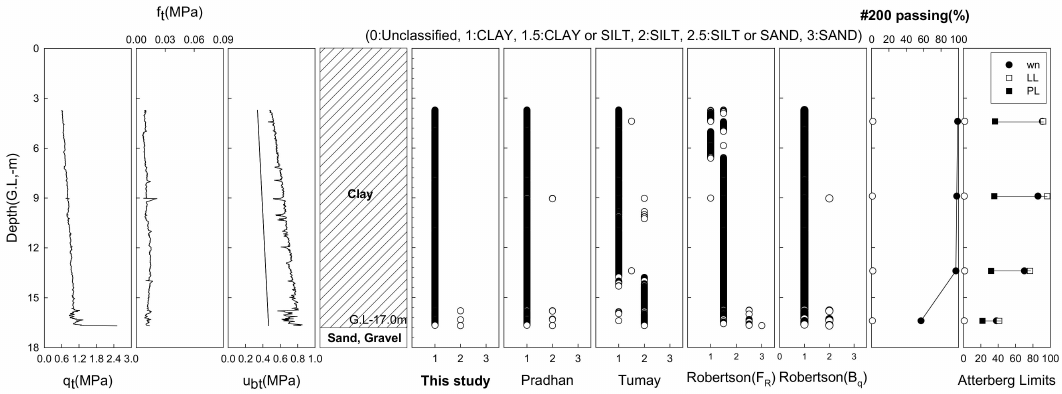
Figure 15. Verification results at Ulsan southern breakwater